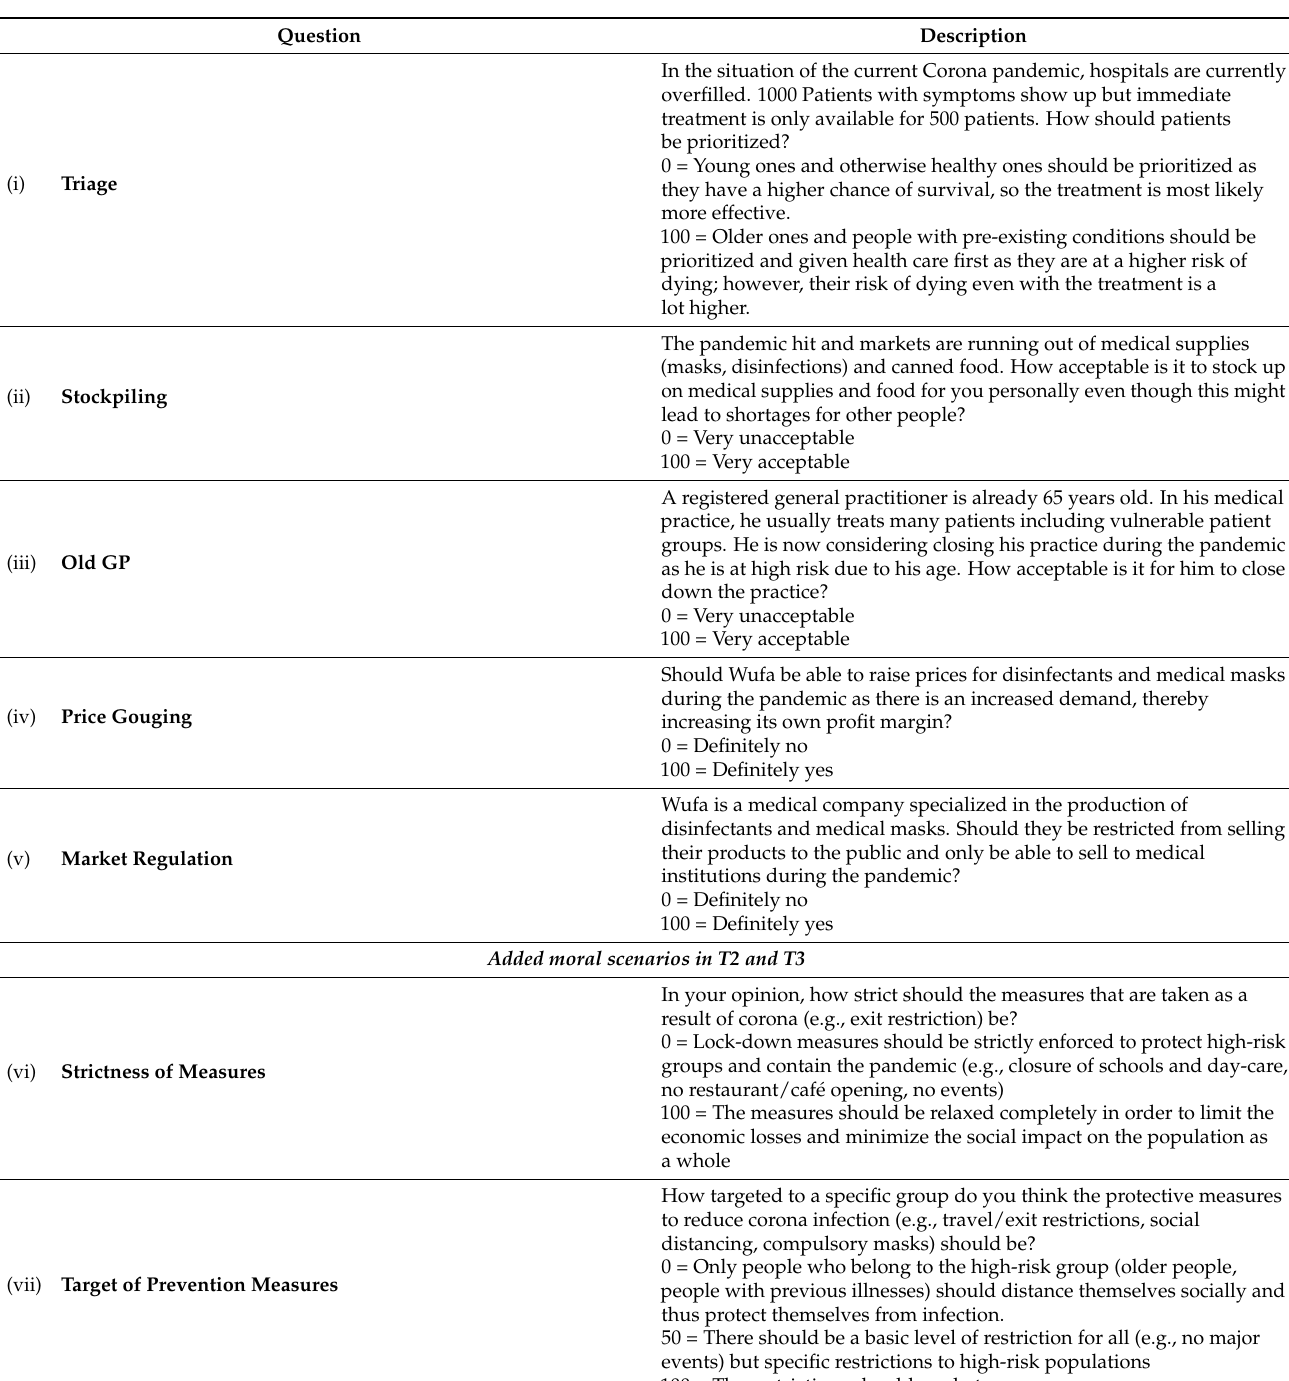
Table 1. Description of the moral scenarios for all time